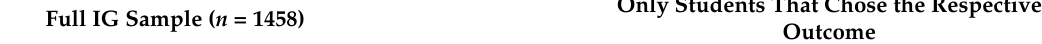
Table 3. Odds ratio with 95% CI for intervention group behavior change compared to the control group—full IG sample and sensitivity analysis including only participants who chose a challenge in the respective health behavior